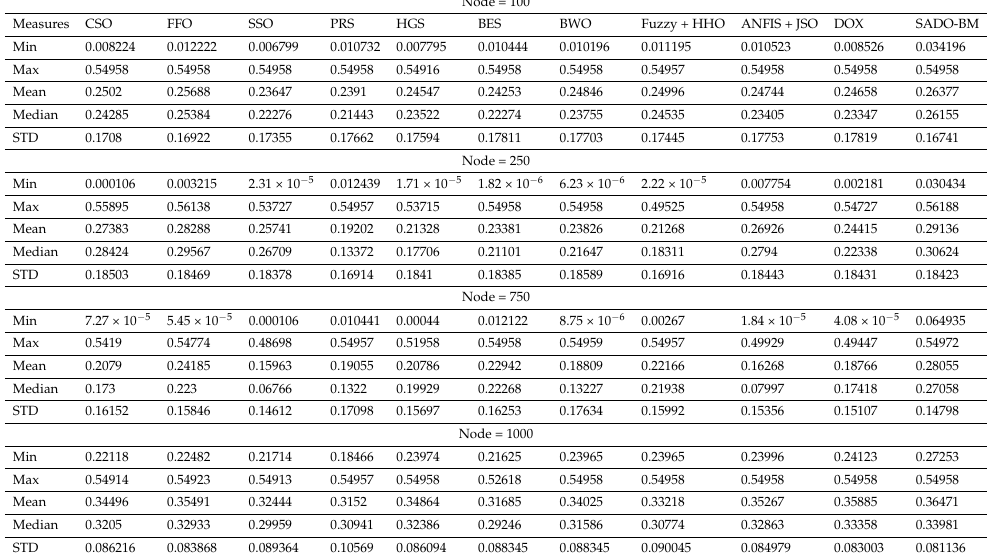
Table 5. Statistical Analysis for SADO-BM over Other Models Regarding Residual Energy.